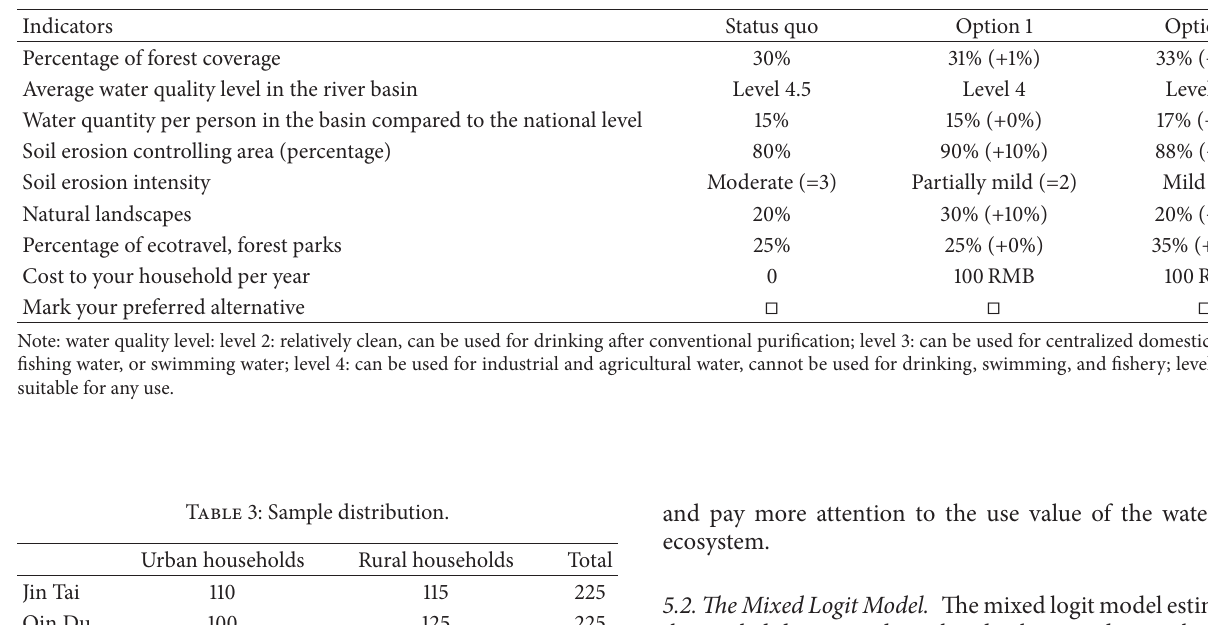
Table 2: A typical example of a choice set in the choice experiment.